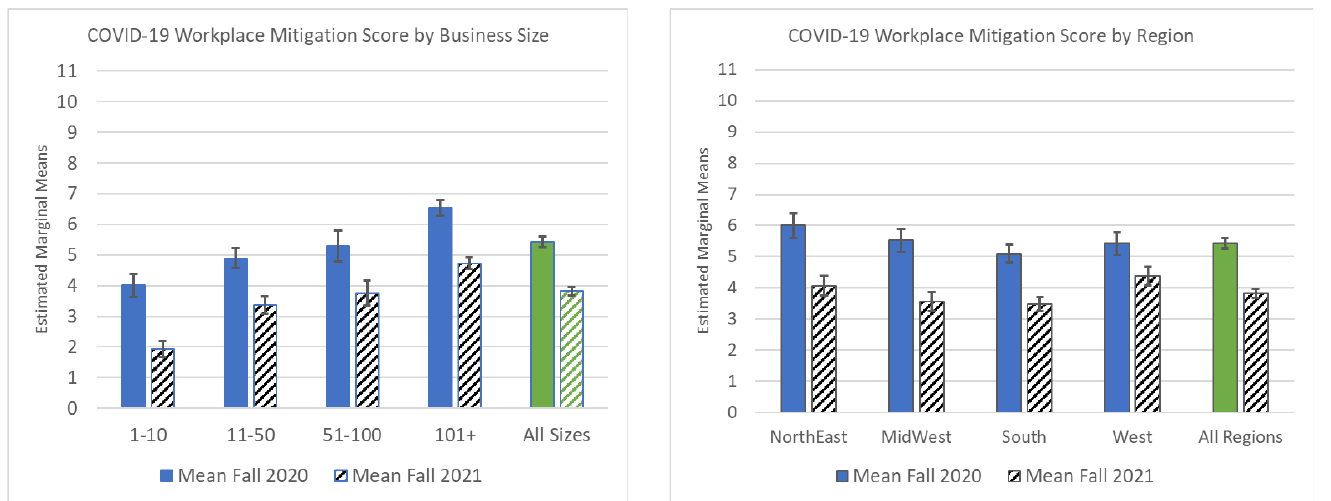
Figure 2. Respondent reported COVID-19 mitigation scores by business size (# employees) and US region, fall 2020 and fall 2021 . and US region, fall 2020 and fall